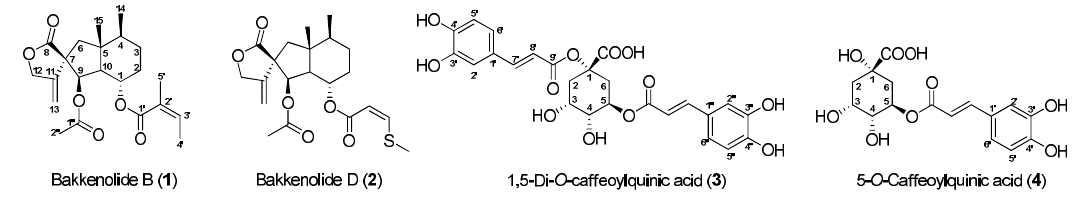
Figure 1. Chemical structures of isolated compounds from the leaves and stems of P. japonica .